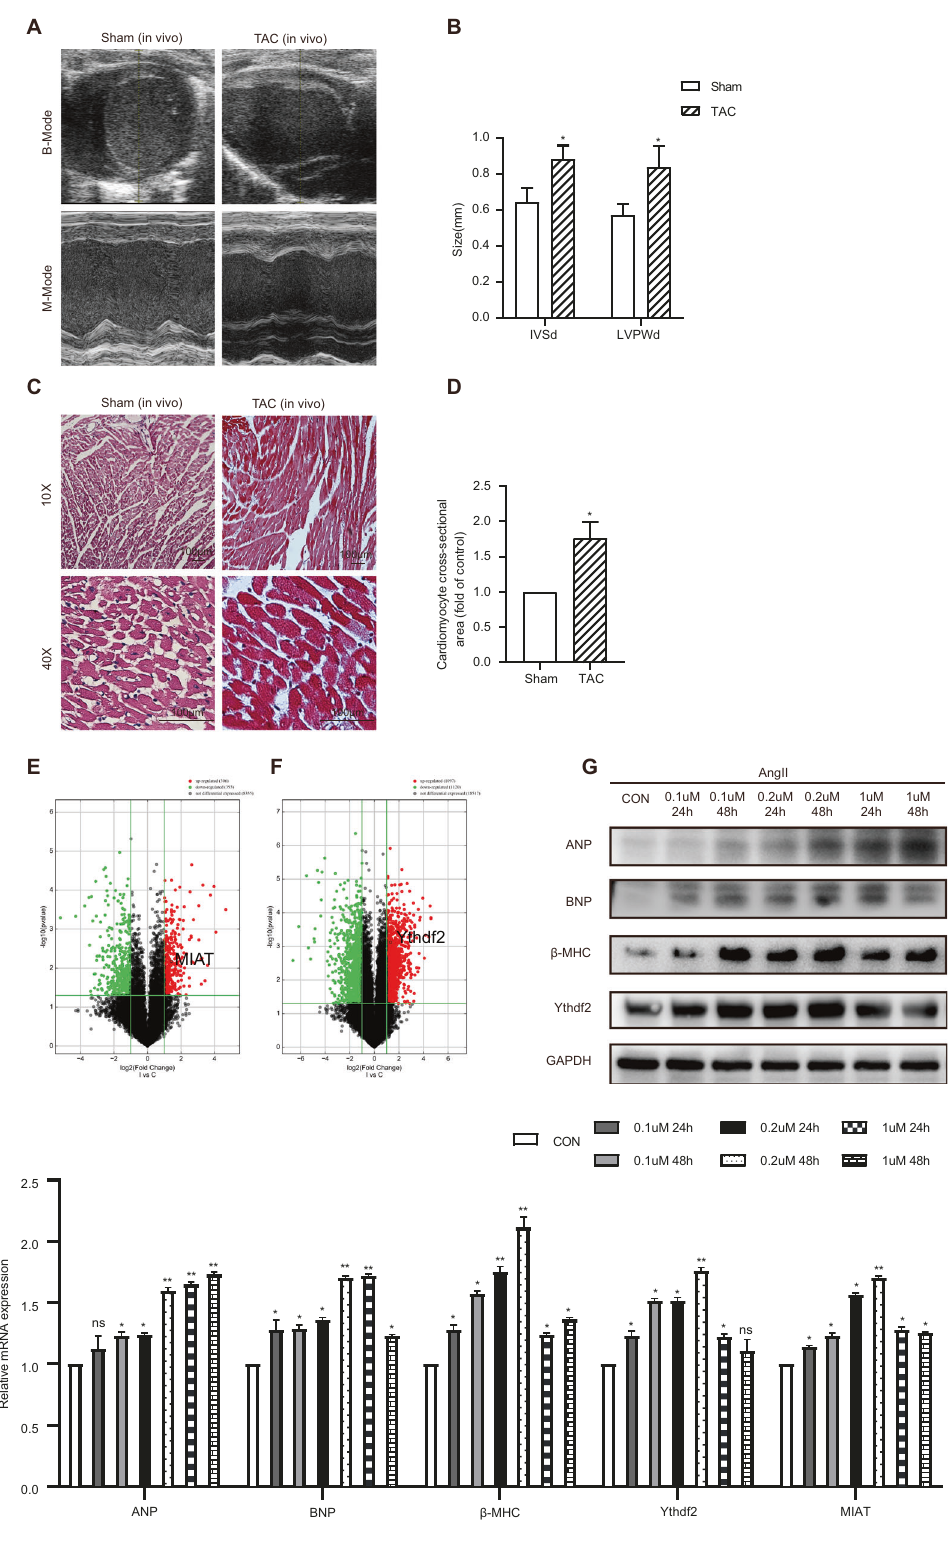
Chromatin immunoprecipitation-PCR (ChIP-PCR) The protocol was referred to the previous article [22]. Brie fl y, the primers of Lnc-MIAT which covered the predicted binding sites of Ythdf2 were designed. Use formaldehyde to cross-link target protein and DNA, and fragment chromatin by sonication. The protein-DNA complex was immunoprecipitated by speci fi c antibody. Then the puri fi ed DNA fragments were analyzed by PCR.